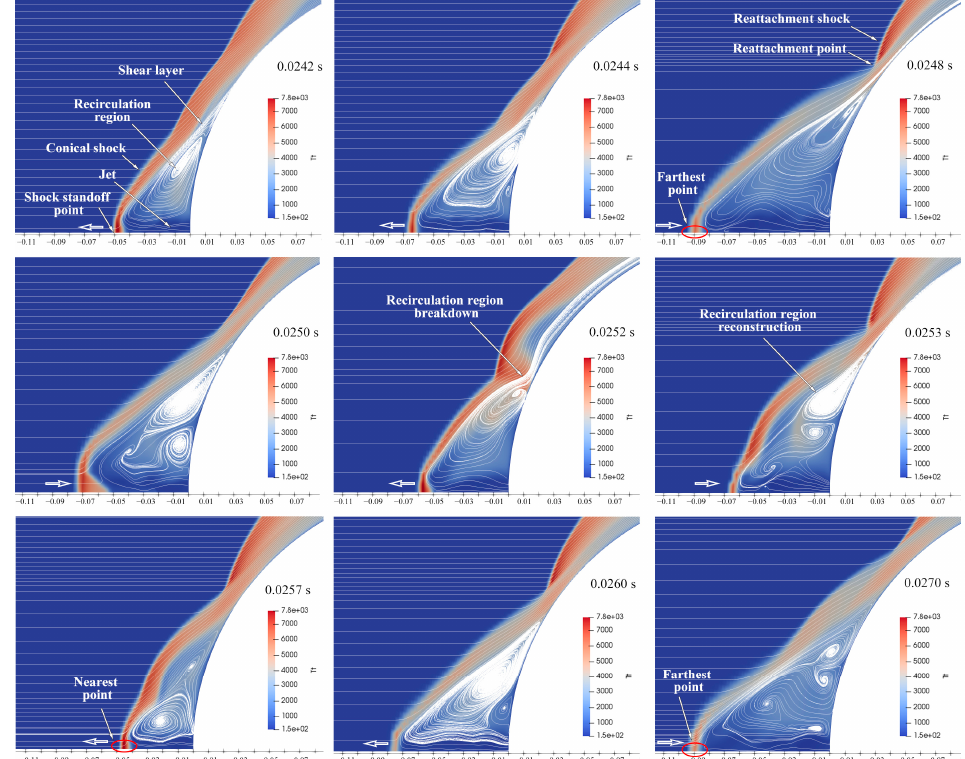
Figure 7. Transient characteristic of LPM.